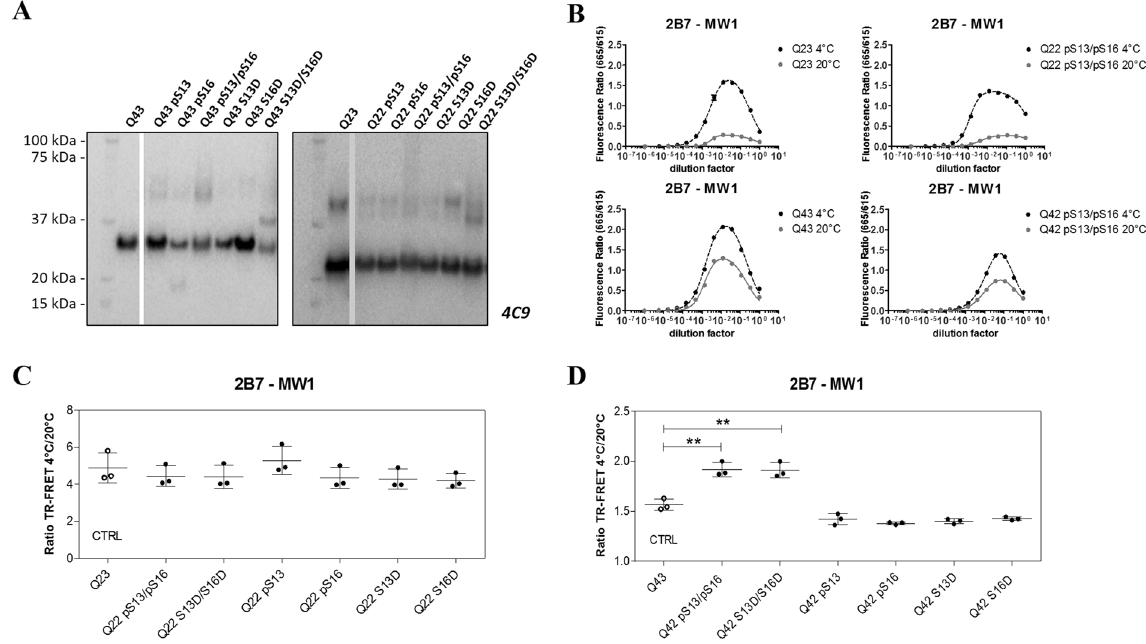
Figure 9. S13/S16 modifications in the N17 domain of HTT alter mHTT conformation as detected by the 2B7/ MW1 conformational immunoassay. ( A ) Western blot of semisynthetic HTT exon 1 proteins (100 ng/lane; Q42/43 and Q23/22) used in this study (detection with mAb 4C9). WB images were cropped from the acquired original file. Full-length blots are reported in Supplementary Information: Figures S4 and S5. ( B ) Upper